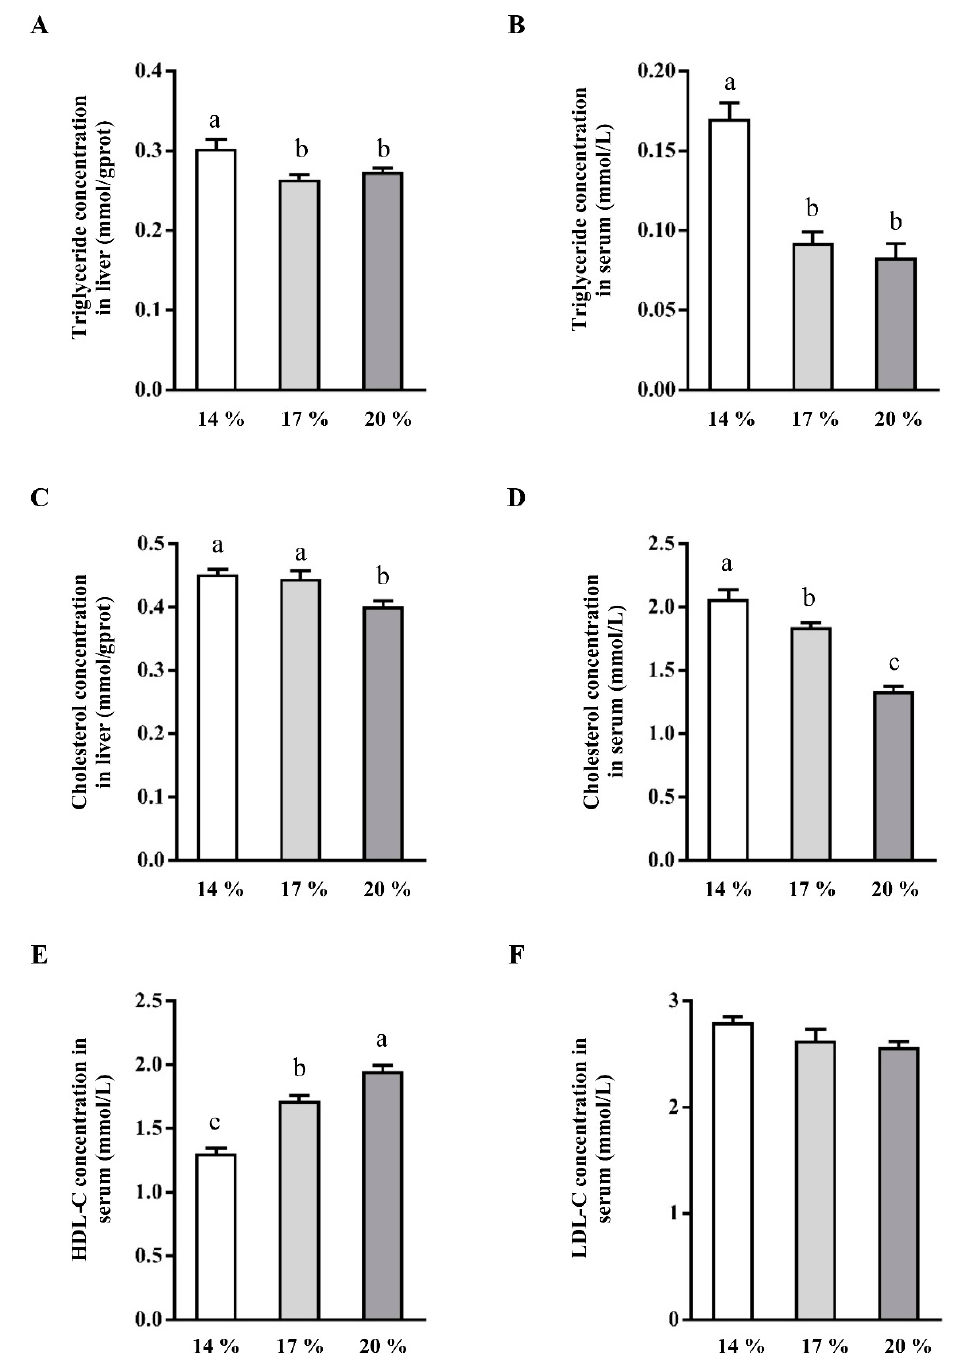
Figure 1. Effect of dietary crude protein level on the concentrations of triglyceride and cholesterol in liver and serum. Triglyceride concentration in liver ( A ) and serum ( B ). Cholesterol concentration in liver ( C ) and serum ( D ). HDL-C ( E ) and LDL-C ( F ) concentration in serum. Values are means ± SEMs, n = 6. Means without a common letter differ, p < 0.05. HDL-C, high-density lipoprotein cholesterol; LDL-C, low-density lipoprotein cholesterol.